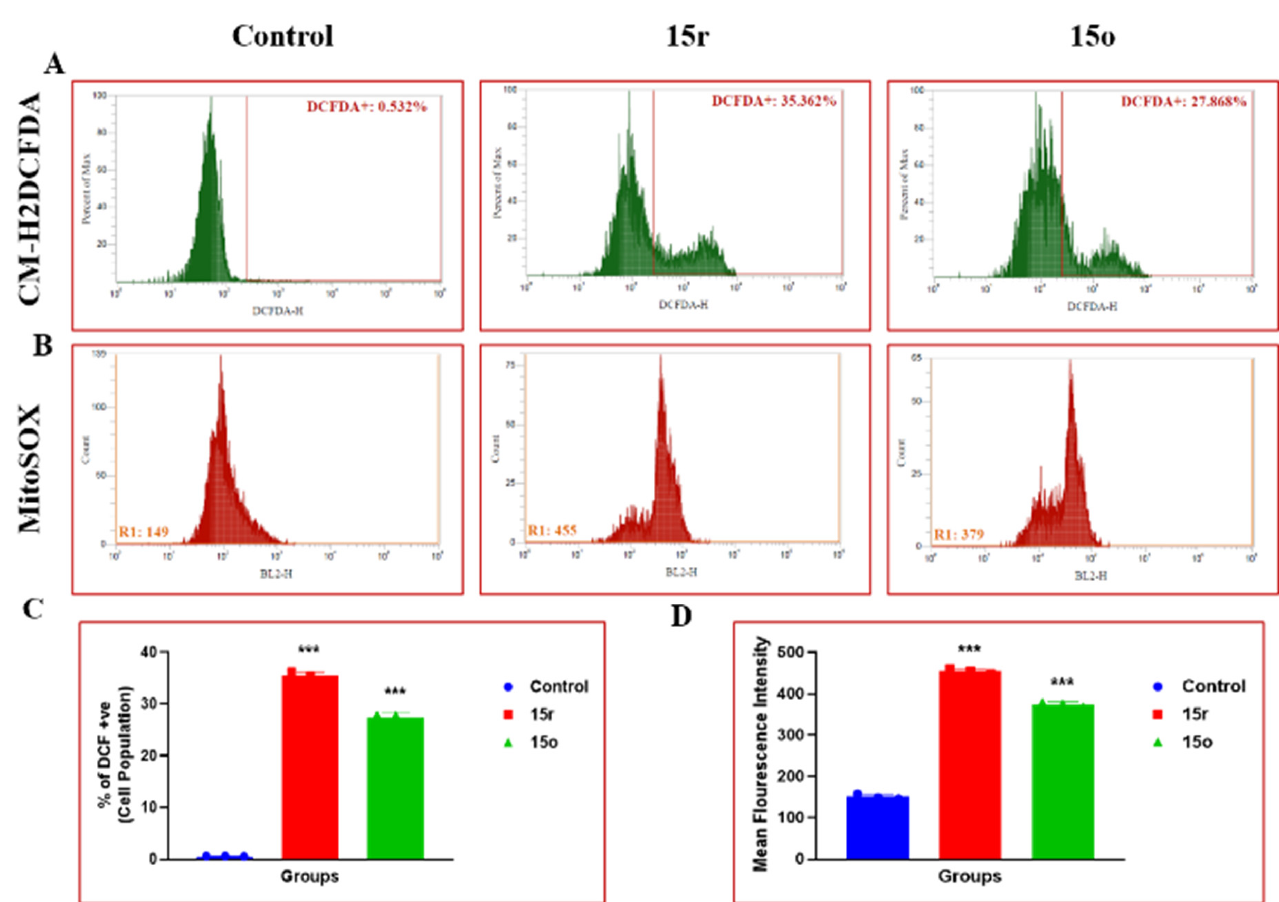
Figure 6. Treatment with 15r (1 µ M) and 15o (2 µ M) on HT-29 cells caused increased production of ROS. ( A ) Flow cytometric analysis graphs depicting% ROS generation in HT-29 cells. ( B ) Intrami- tochondrial superoxide production was significantly enhanced in HT-29 cells after treatment with 1,2,4-triazolo-linked bis -indolyl conjugate ( 15a–r ) derivative compounds 15r (1 µ M) and 15o (2 µ M), as measured by mitochondrial-localising MitoSOX Red fluorescence probe. ( C ) Bar representation for mean fluorescence intensity of compounds 15r and 15o . ( D ) Representative flow cytometry histograms of MitoSOX Red fluorescence in HT-29 cells (10,000 cells). Statistical significance was determined by one-way ANOVA followed by Tukey’s post-hoc analysis, where *** p < 0.001 represents control vs. 1,2,4-triazolo-linked bis -indolyl conjugates ( 15o and 15r ) in the treatment